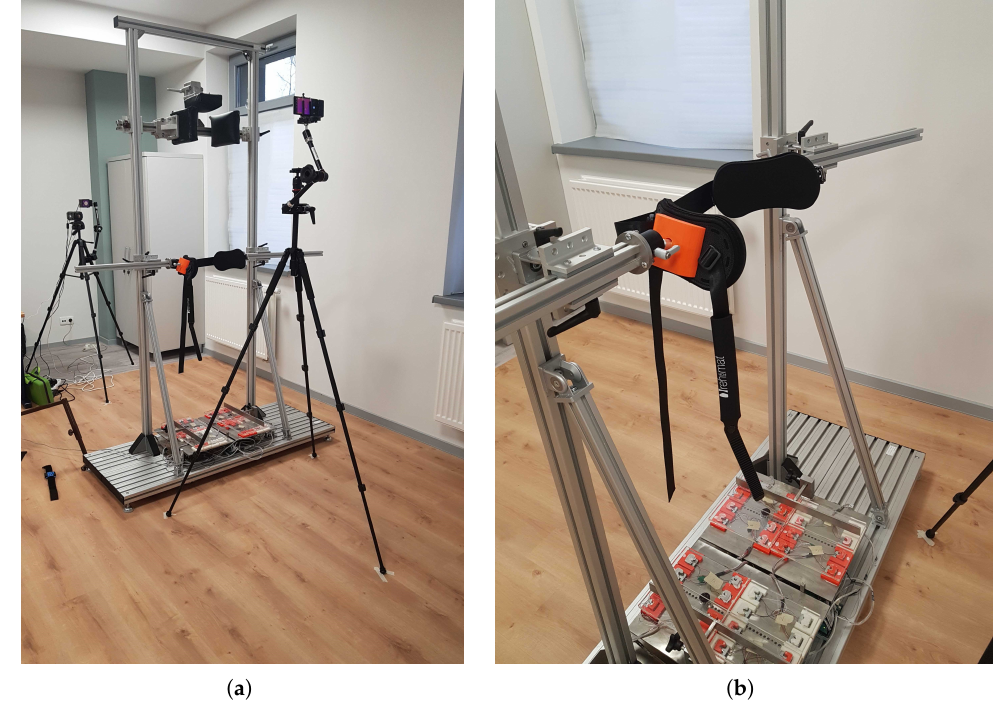
Figure 1. ( a ) A prototype of the D4S module for exercises in the standing position with measuring devices and ( b ) a belt fastened on the patient’s pelvis and a